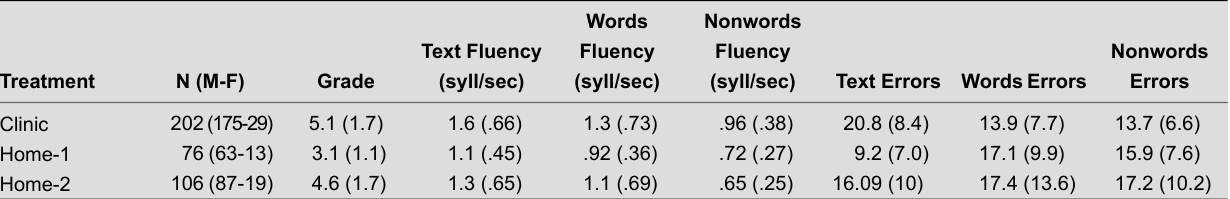
Means and standard deviations (in parenthesis) at baseline of main demographic and reading measures of participants of the three